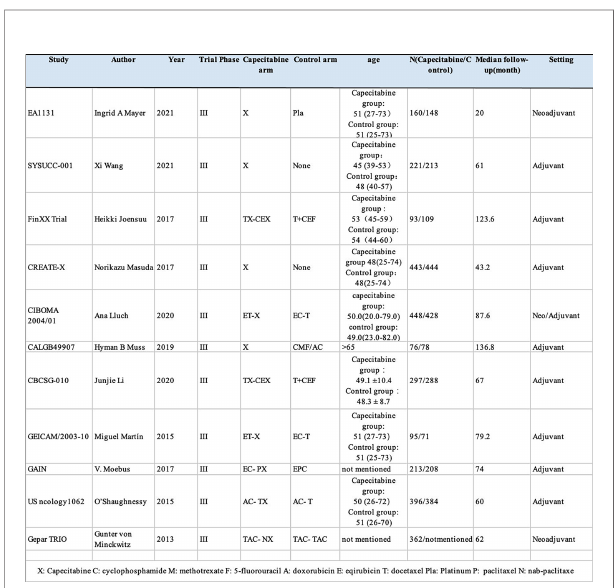
FIGURE 2 | The baseline